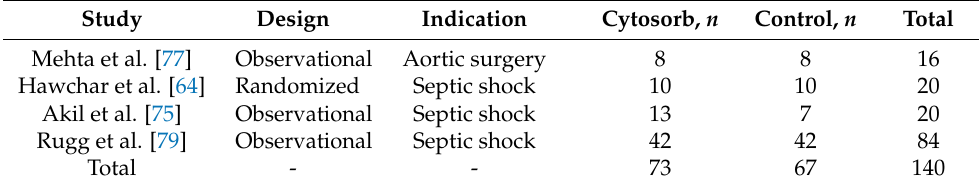
Table 1. Studies with Cytosorb and control cohorts.